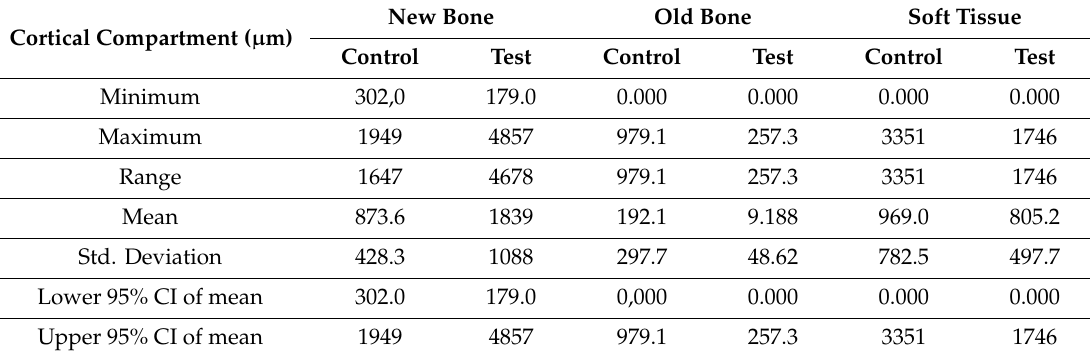
Table 2. Tissues quality at the level of the implant surface in the cortical portion.